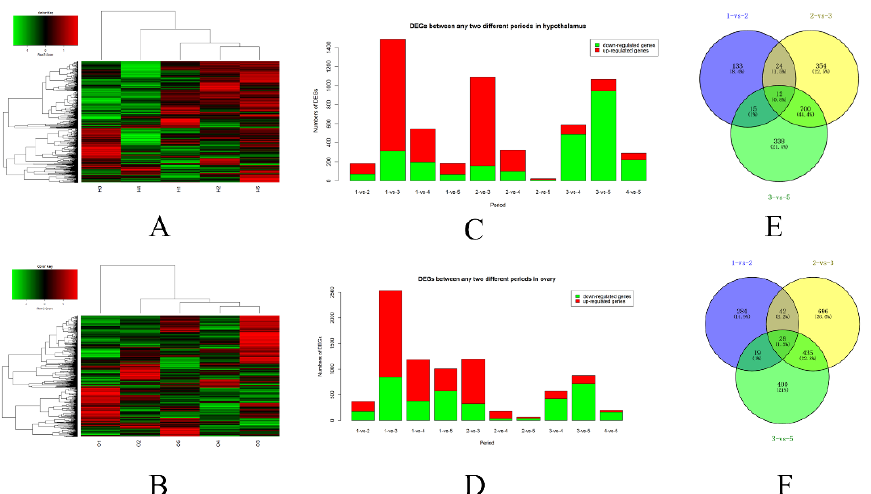
Figure 2. Transcriptome analysis of hypothalamus and ovary in 5 periods during FM. Overall pro- files of mRNA expression in the hypothalamus ( A ) and ovary ( B ). DEGs between any two different periods in the hypothalamus ( C ) and ovary ( D ). Venn diagram shows the DEGs from the 1-vs-2, 2- vs-3, and 3-vs-5 comparisons in the hypothalamus ( E ) and ovary ( F ).